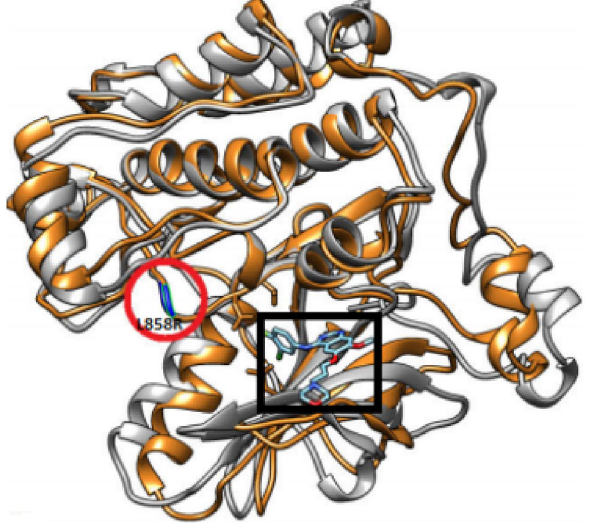
Figure 1. An EGFR-Gefitinib complex modeled with the L858R mutation. The drug molecule is indicated by the black square and the mutation by the red circle. The image was generated using